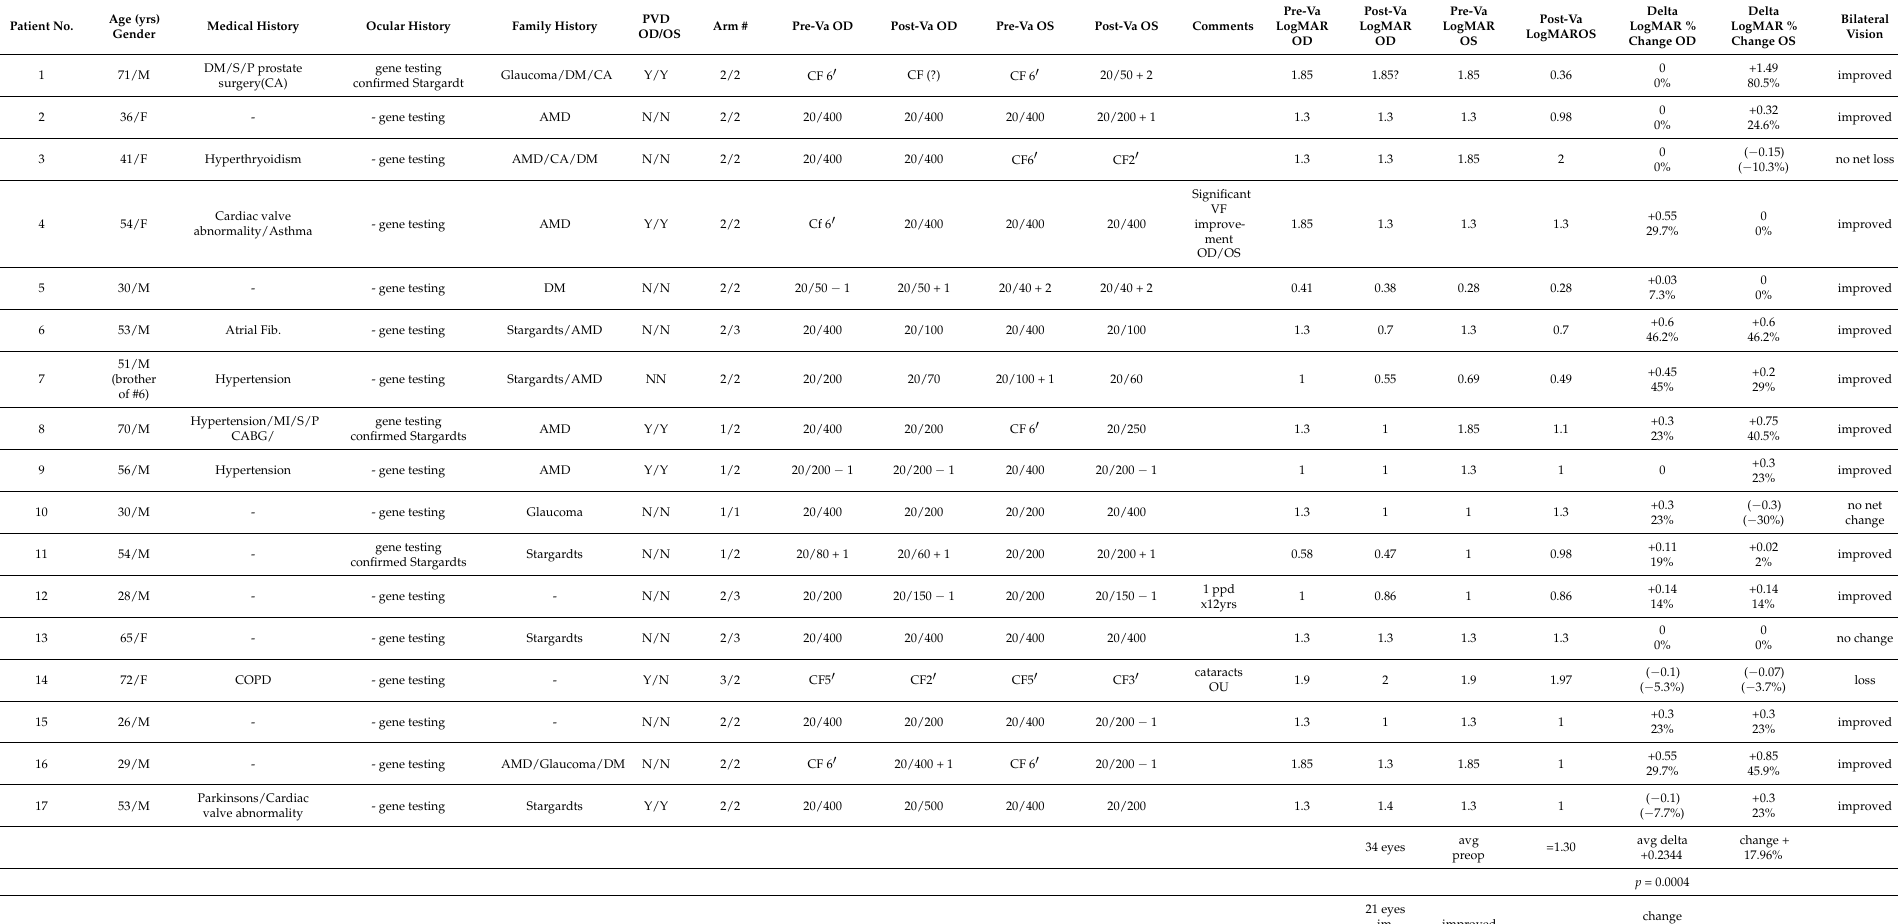
Table 2. A summary of each patient’s demographic data, Snellen Acuity pre and post treatment, LogMAR pre and post treatment, percent vision change, and bilateral vision results.